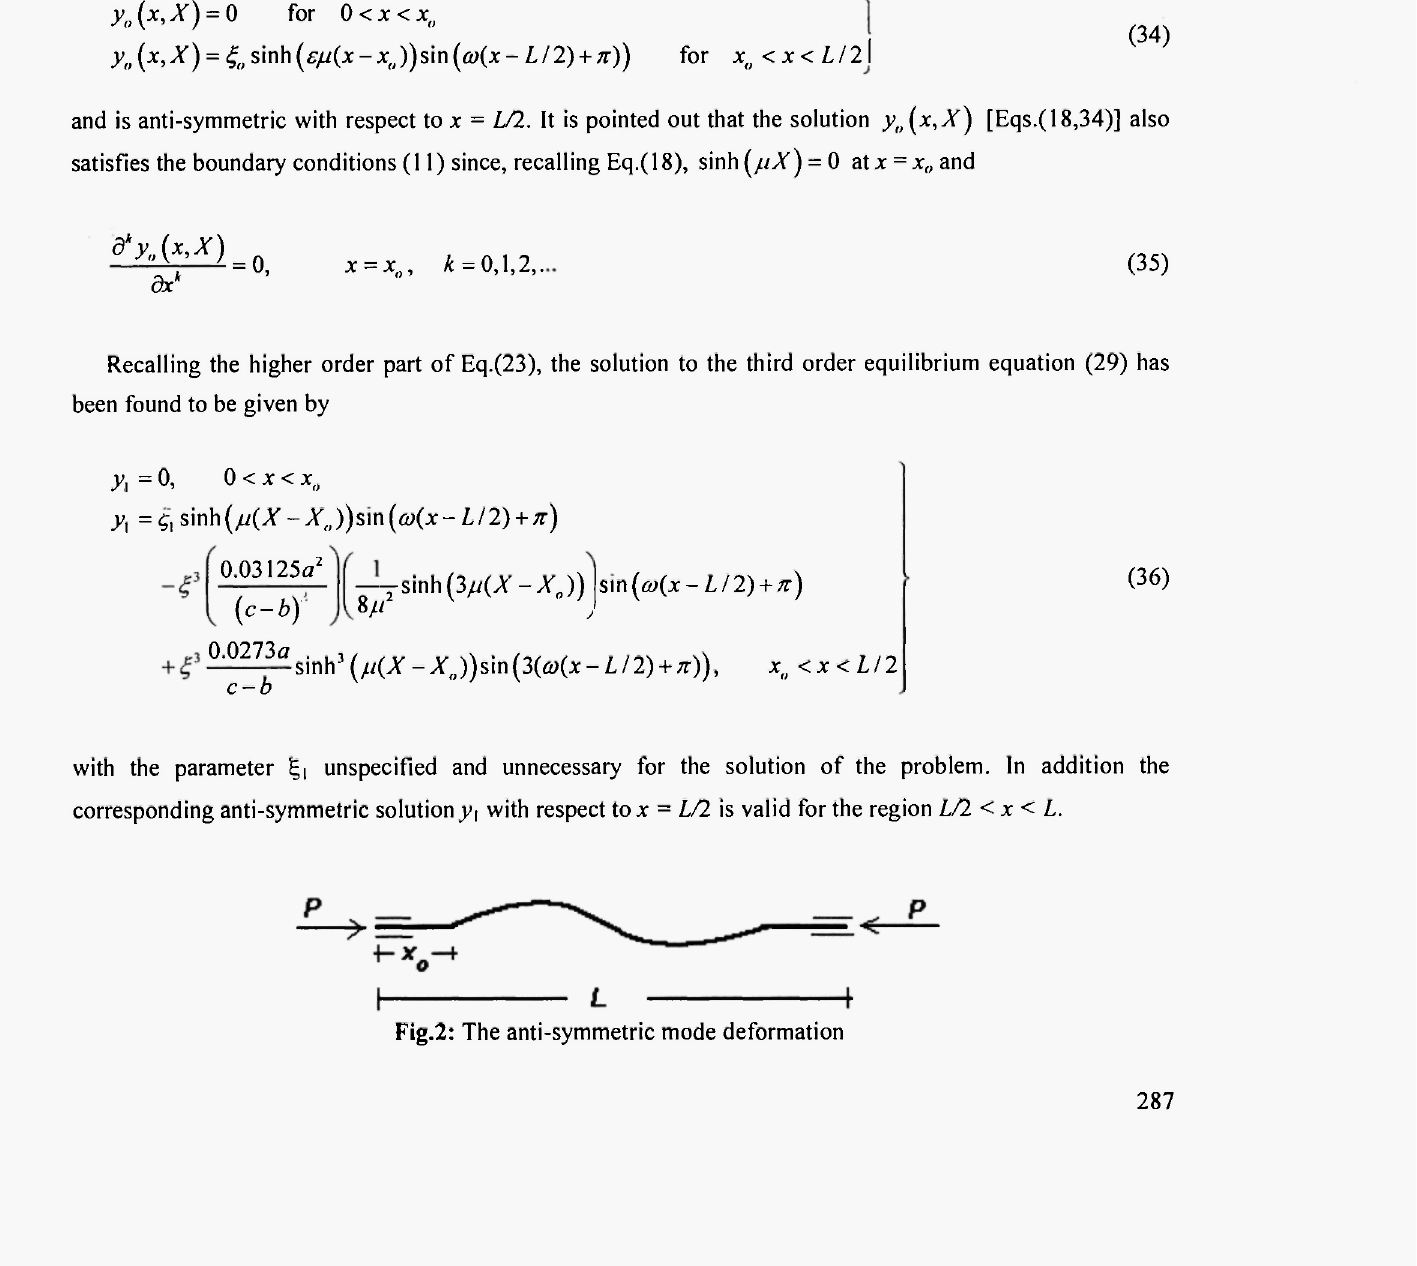
Fig.2: The anti-symmetric mode